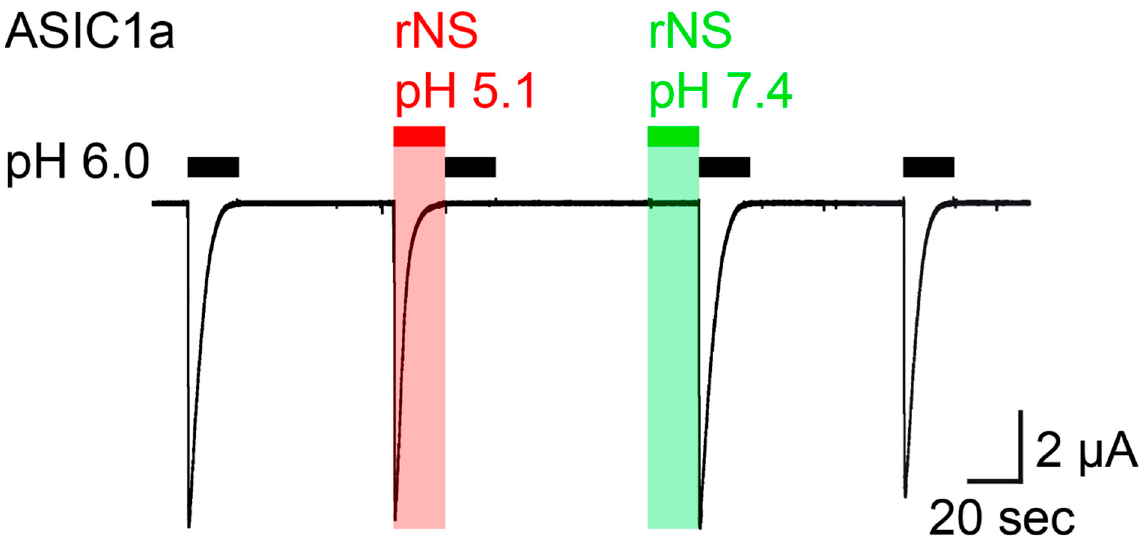
Figure 1. Nocistatin does not activate ASIC1a in Xenopus oocytes. Current trace recorded from a rASIC1a-expressing oocyte stimulated repetitively with pH 6.0 for 20 s (black bars); conditioning pH 7.4 was applied for 60 s. Rat nocistatin (rNS, 0.5 mM) in pH-unadjusted (pH 5.1, red bar) und pH-adjusted (pH 7.4, green bar) conditioning solution was applied for 20 s. This trace is representative for 5 similar measurements.